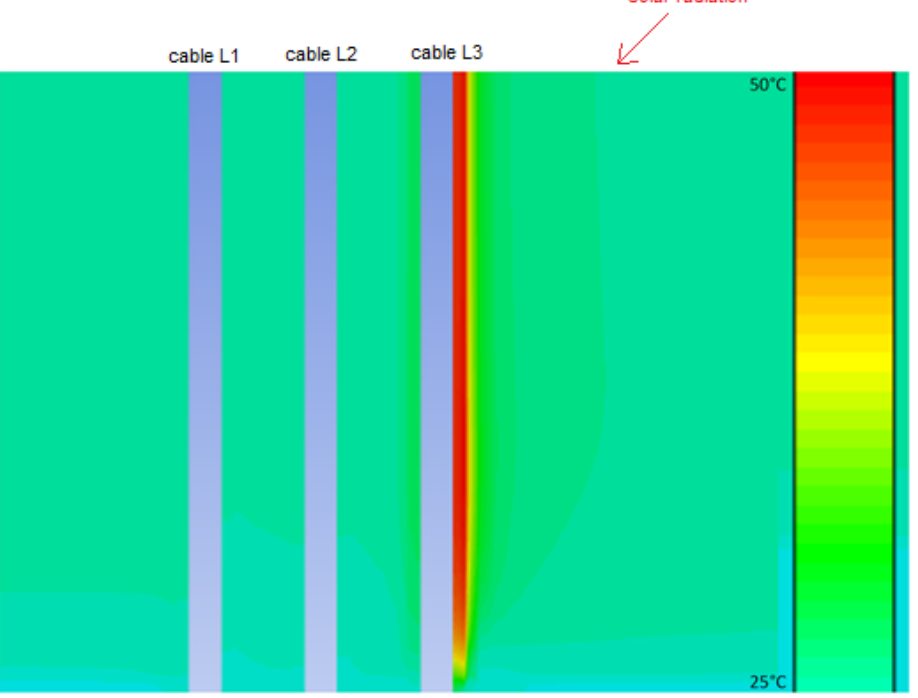
Figure 3. Temperature distribution around unloaded power cables ( I Z = 0 A) taking into account solar radiation (close-up view of the cables).